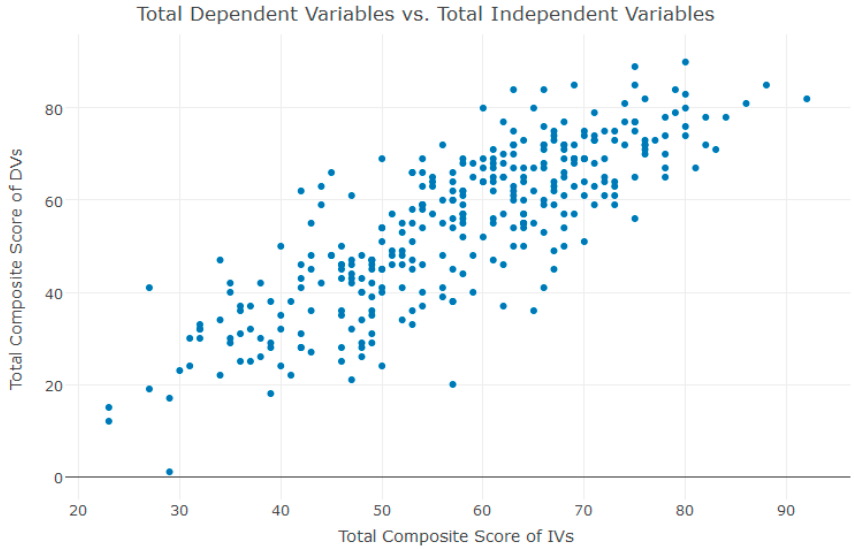
Figure 5. Scatter plot between the total composite scores of SWB explanatory questions and SWB measures. DVs—dependent variables; IVs—independent variables. measures. DVs—dependent variables; IVs—independent